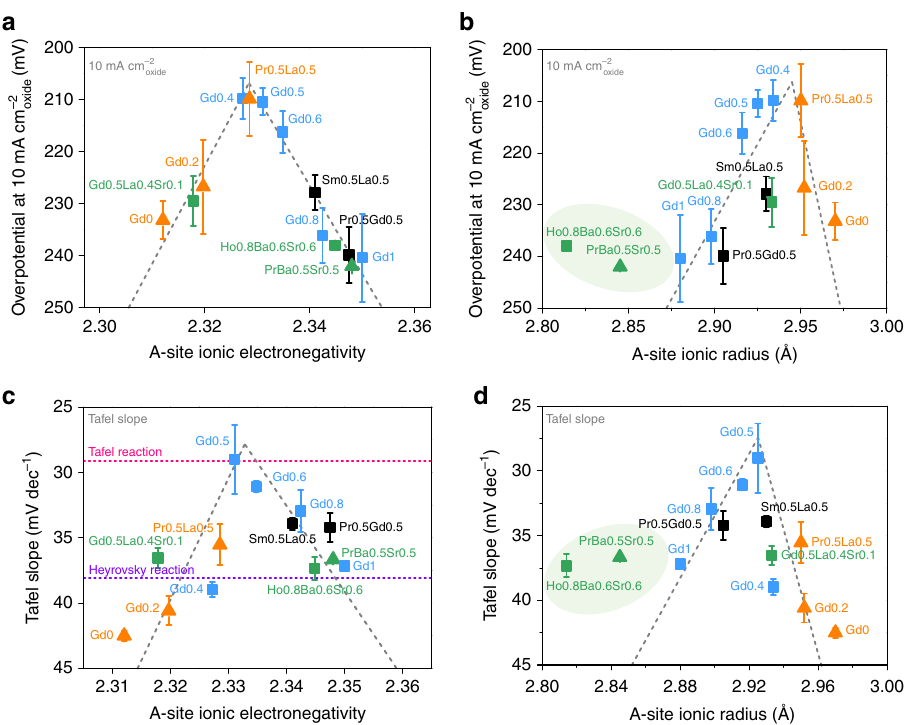
Fig. 2 Correlation with intrinsic HER activity. HER activity trends of overpotential at 10 mA cm − 2 oxide as a function of a A-site ionic electronegativity, and b A-site ionic radius for single and double perovskites studied here. Plots of Tafel slope values as a function of c A-site ionic electronegativity (the rate- determining steps estimated from the Tafel slope are shown in pink and purple dashed lines), and d A-site ionic radius for the prepared single and double perovskites. Error bars stand for the standard deviation (s.d.) of three independent HER measurements performed in 1.0 M KOH at 25 °C and the gray dashed lines are shown for guidance only. Triangles and squares represent the single and double perovskites, respectively. Sr-doped perovskites (green) and perovskites doped with different lanthanides (Sm0.5La0.5 and Pr0.5Gd0.5 in black) are shown in distinguished